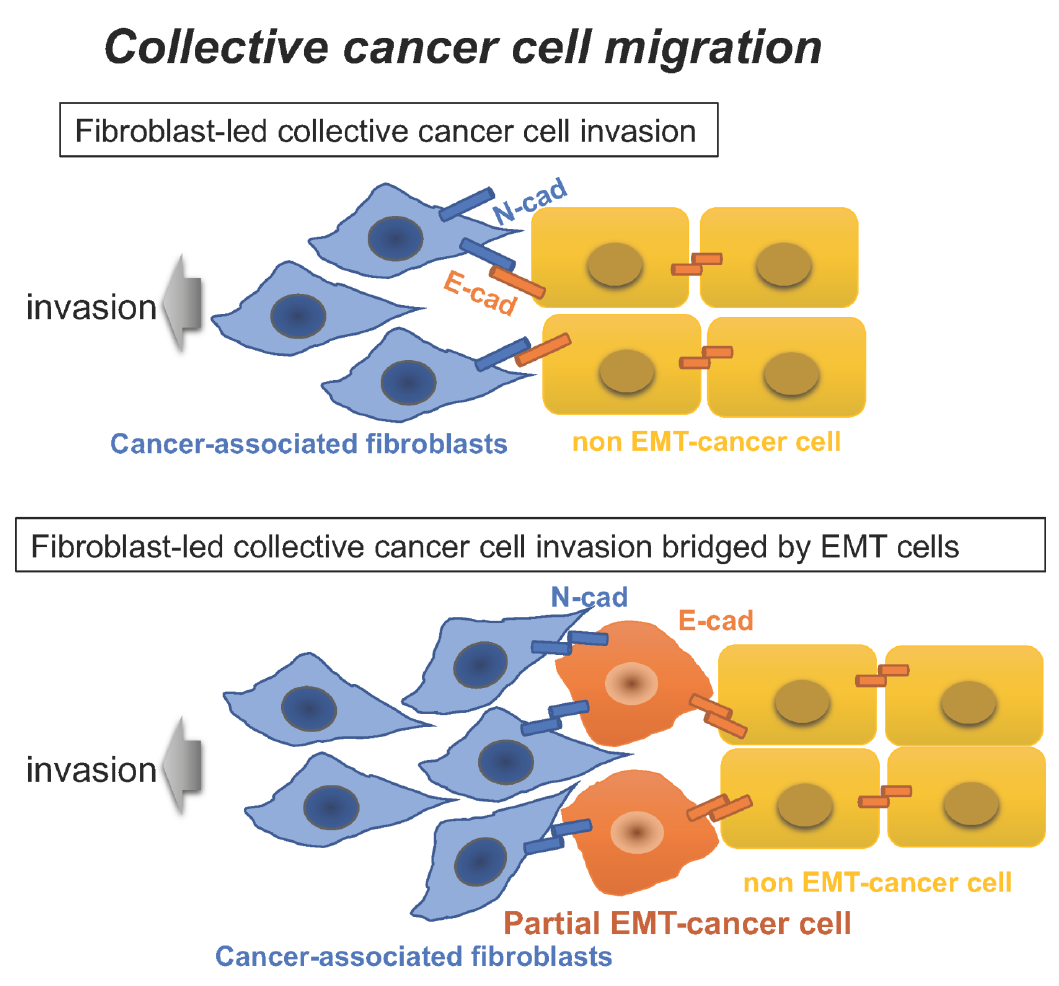
Figure 2. Collective cancer cell migration. Collective cancer cell migration is characterized by multicellular clusters analogous to a bunch of grapes, and includes fibroblast-led collective cancer cell migration/invasion (top) and promotion of invasion of non-EMT cancer cells through the interaction between non-EMT cancer cells and cancer-associated fibroblasts, which is bridged by EMT-cancer cells (bottom). N-cad, N-cadherin; E-cad, E-cadherin. Collective cancer cell migration exhibits multicellular clusters resembling a bunch of grapes and depends on cell – cell adhesion through epithelial adhesion molecules of solid cancer cells [15]. On the other hand, single cancer cell migration depends on integrin-me- diated interactions between cancer cells with a mesenchymal trait and ECM. In pancreatic cancer, active K-RAS mutations are very frequently detected. During the early stages of carcinogenesis, active RAS signals result in the sustained activation of MAPK pathways, which reportedly help overcome the cancer suppressing effects of TGF- β by promoting Smad degradation (Figure 1) [16]. When active K-RAS mutations are introduced in normal epithelial cells which had been sensitive to growth inhibition by TGF- β, they confer re- sistance to TGF- β ( Figure 1). Thus, these normal epithelial cells with active K-RAS